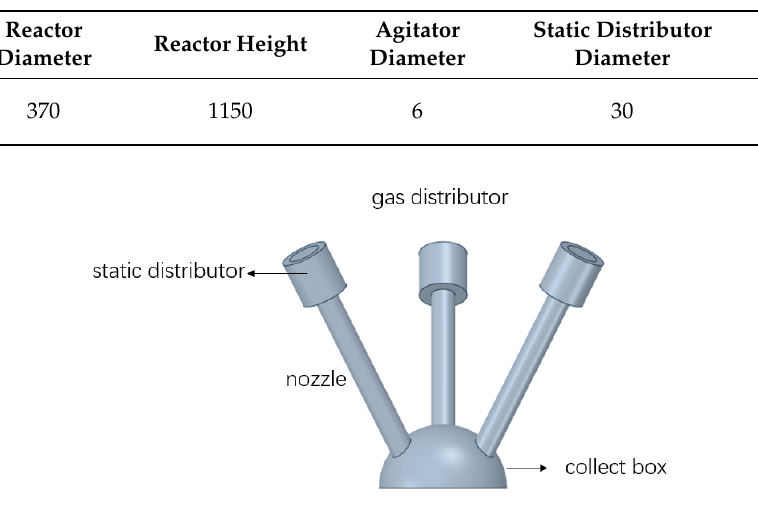
Figure 5. Geometric model of stirred tank Taylor reactor. Table 1. Reactor size parameter.